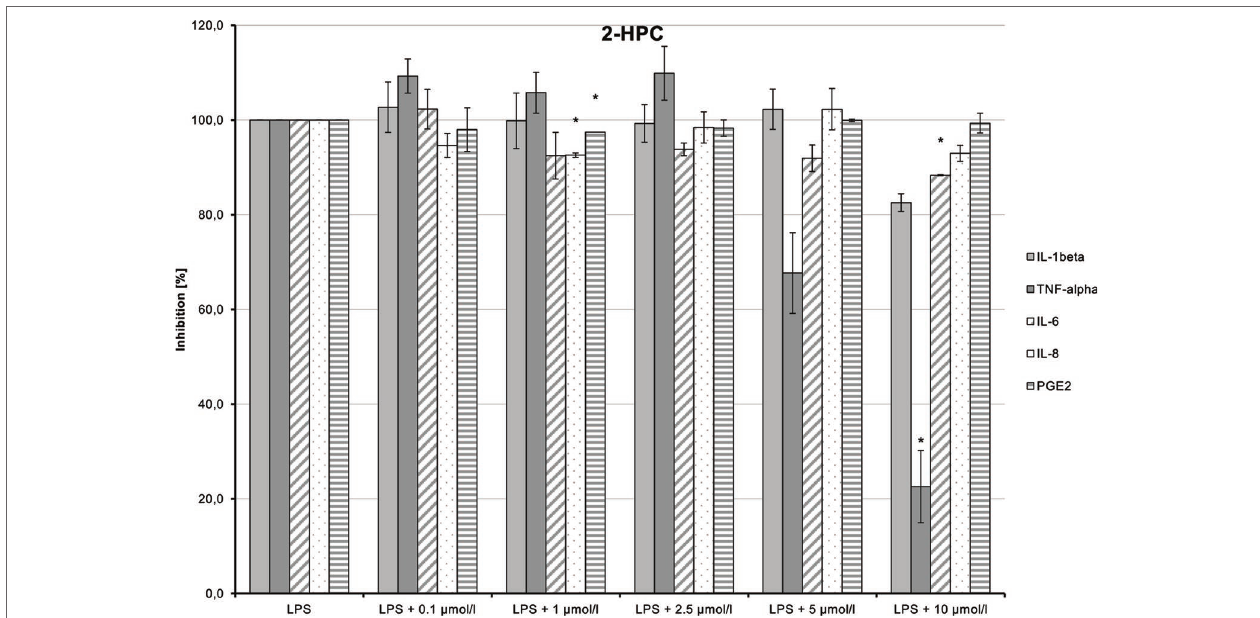
FigURE 12 | Anti‑inflammatory effect of 2,3‑dihydroxypropyl cannabidiolate (GCBD) on primary human monocytes; normalized to the induction by lipopolysaccharide (LPS) (without the addition of test compounds); n = 2 independent experiments; error bars show SEM, * p < 0.1.